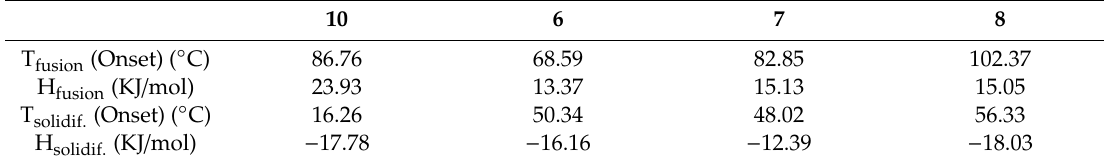
Figure 5. Stacked dynamic scanning calorimetry (DSC) spectra of all target compounds. The DSC experiments were performed with crystals with a heating rate of 0.5 K / min and a flow of nitrogen gas of 20 mL / min. As an example, compound 10 was analyzed after three cycles by 1 H- and 13 C{ 1 H} NMR spectroscopy and showed no degree of decomposition. Table 8. Results of the thermoanalytic